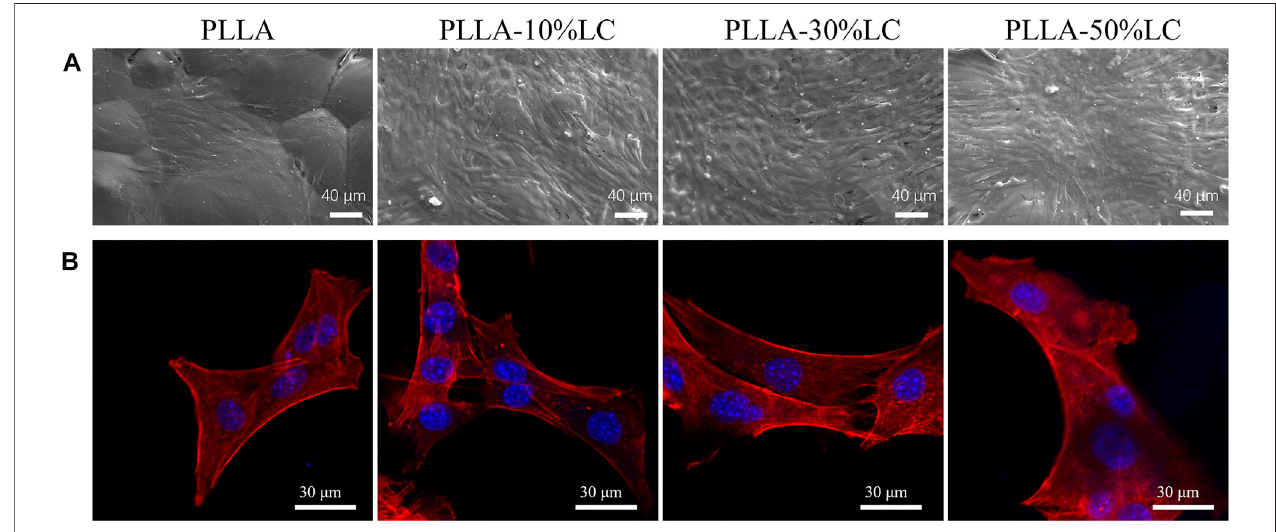
FIGURE 3 | (A) SEM images of morphologies of MC3T3-E1 cells culturing on pure PLLA, PLLA-10% LC, PLLA-30% LC, and PLLA-50% LC fi lms for 3 days; (B) CLSM images of morphologies of MC3T3-E1 cell culturing on pure PLLA, PLLA-10% LC, PLLA-30% LC, and PLLA-50% LC fi lms for 1